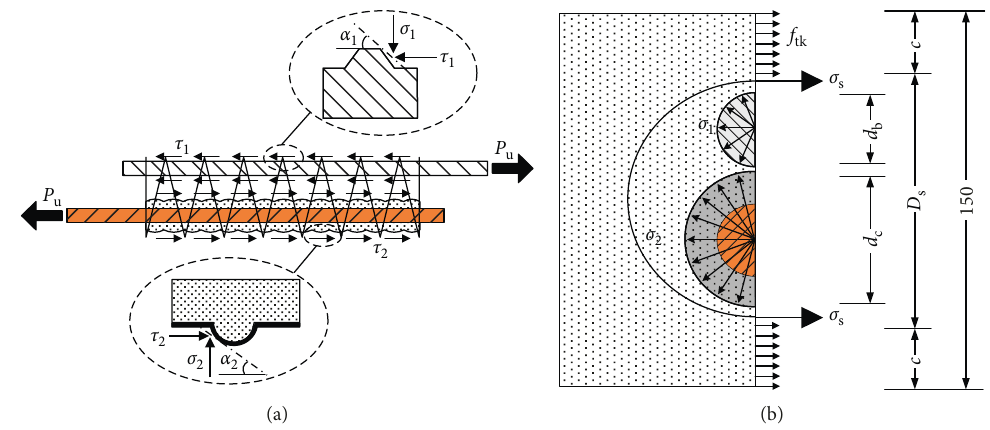
Figure 8: Free body diagram. (a) Axial forces equilibrium. (b) Hoop forces